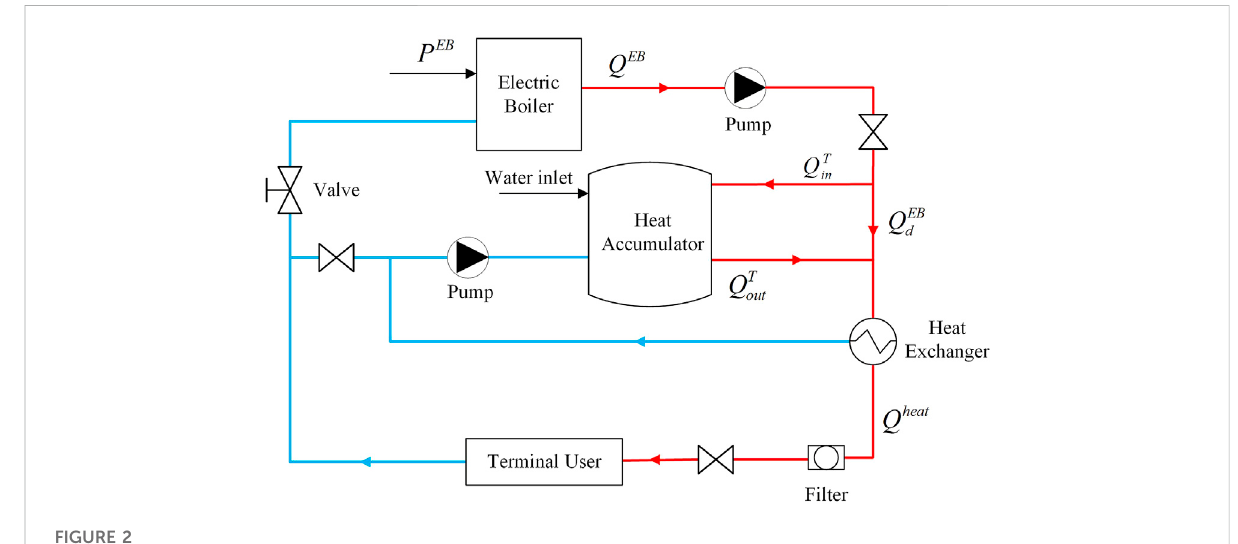
FIGURE 2 Regenerative electric boiler structure.